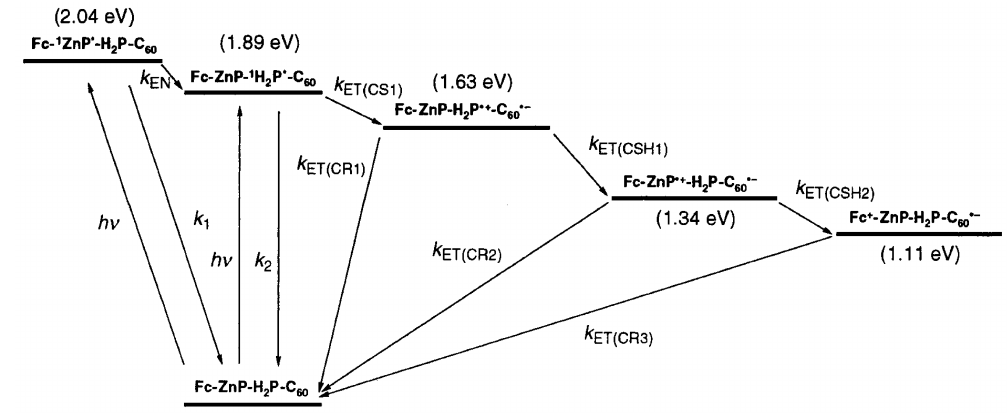
Cascade of energy transfer ( k unusually large CT state lifetime of 0.38 s. Reprinted with permission from [32]. Copyright 2001 by The American Chemical